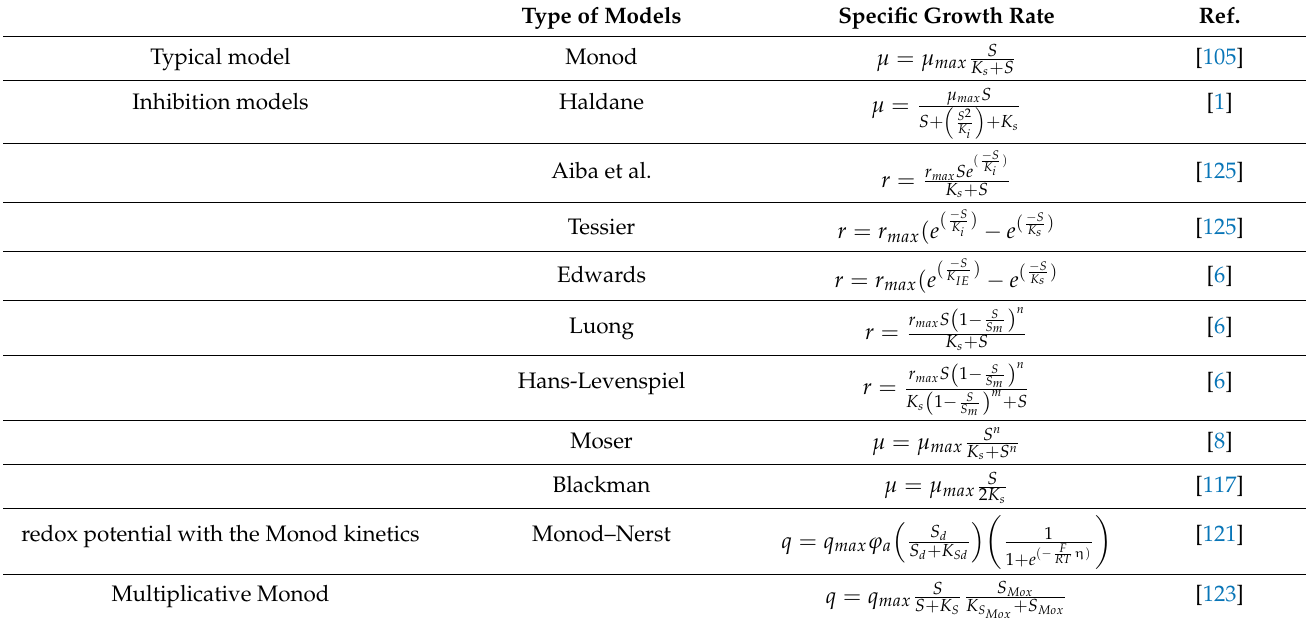
Table 3. Common microbial growth kinetics models used in MFC